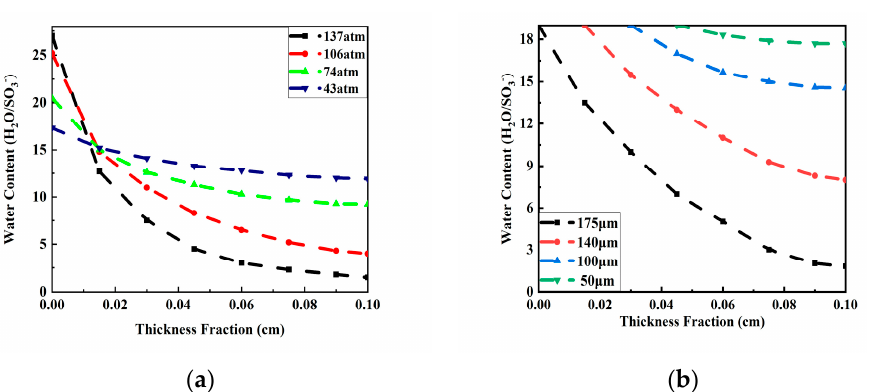
Figure 6. Water profiles in the FO membrane for four osmotic pressures when the circuit was held open. The negative electrode is on the left, and the net water flux moves from right to left ( a ). Profiles of the membrane water content for different membrane thicknesses ( b ).